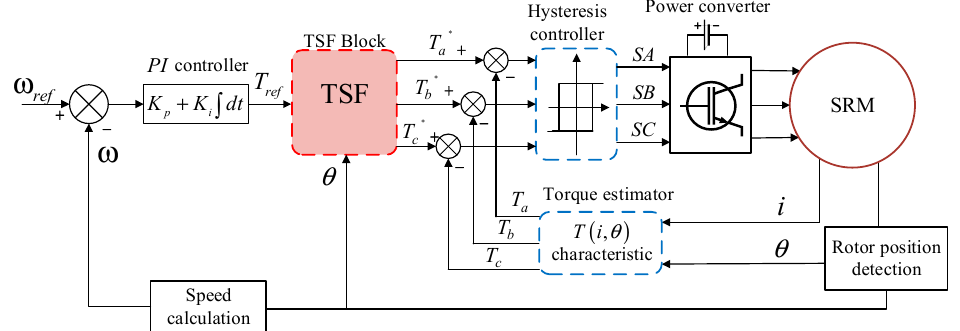
Figure 3. Block diagram of the conventional TSF system.